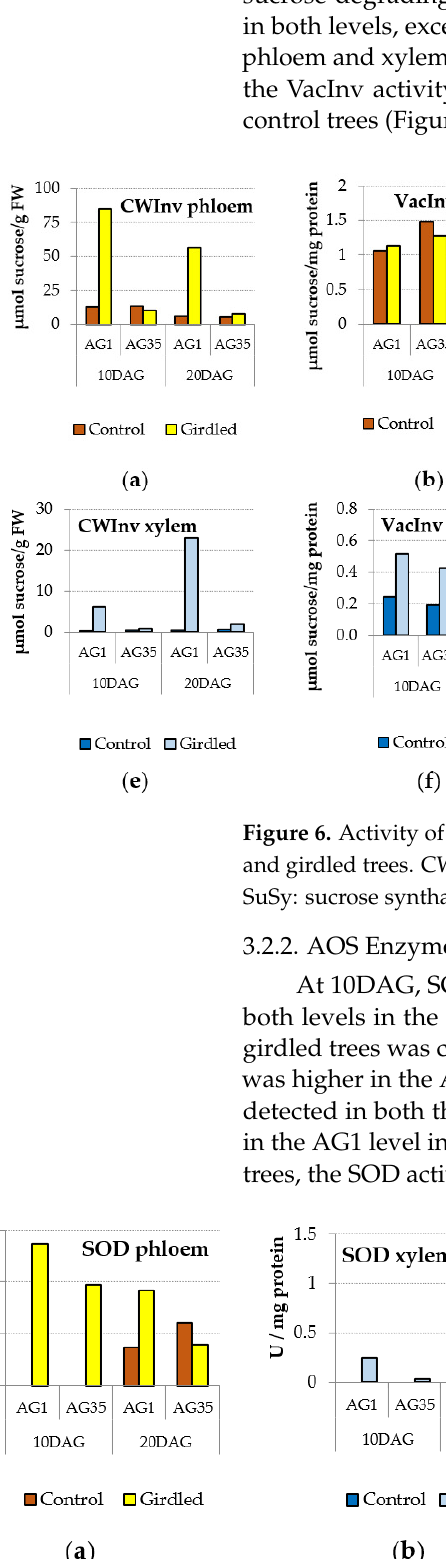
11 of 24 Figure 5. Anatomical characteristics of conducting tissues: ( a ) the proportion of different cell types in late phloem; ( b ) the proportion of different cell types in xylem in AG35 level; ( c ) length of vessel